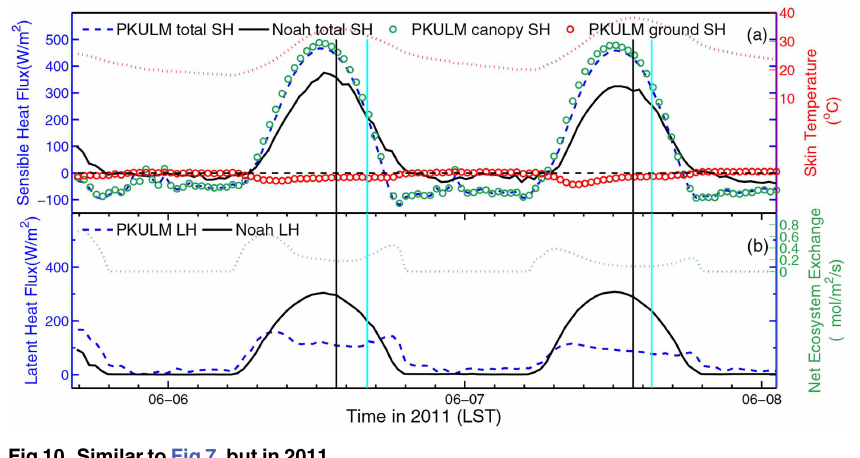
Fig 10. Similar to Fig 7, but in 2011.